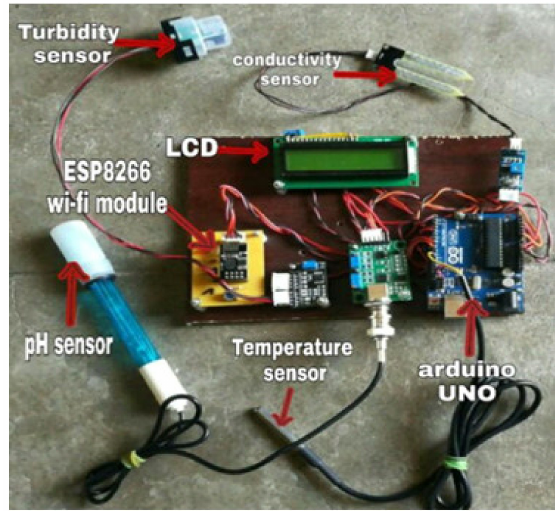
Figure 7. Image of system proposed in